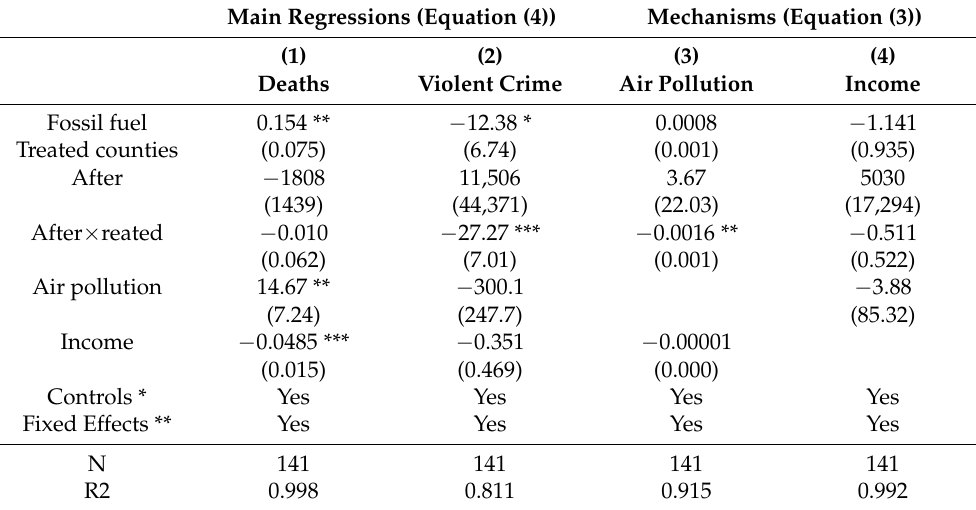
Table 4. Using the integrated mechanism approach based on DiD method (Equations (3) and (4)), when air pollution and income level are the mechanism and fossil fuel consumption is the independent variable: